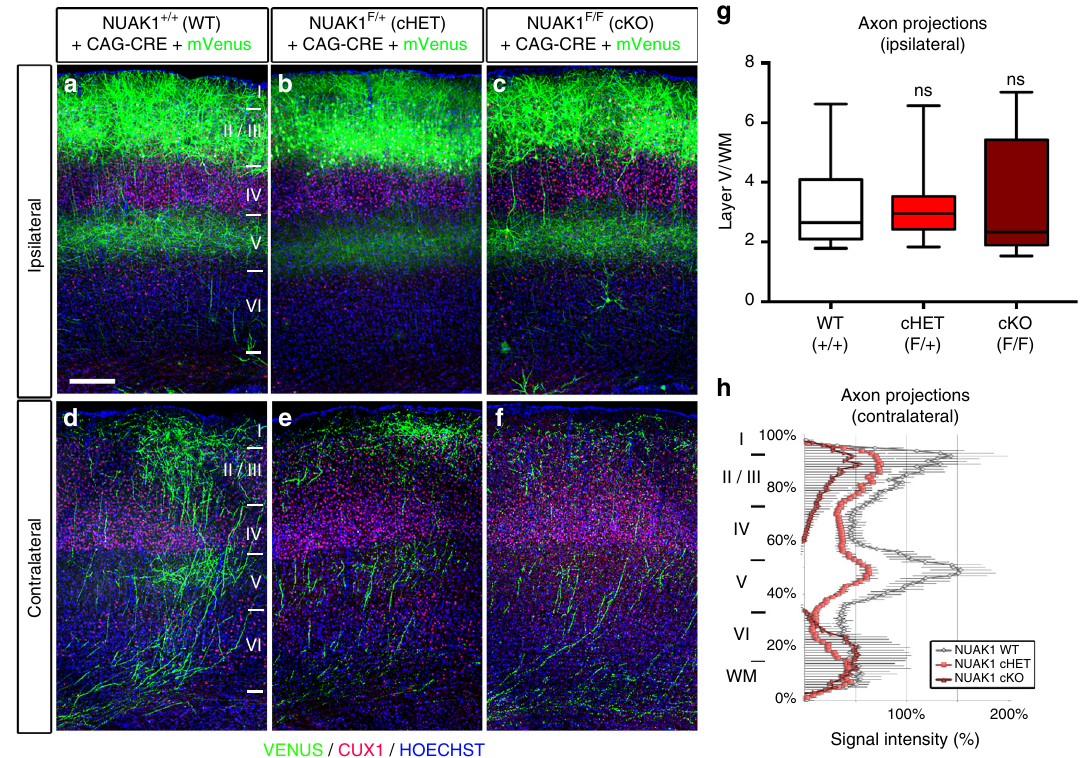
Fig. 5 Cell autonomous reduction in axon branching of NUAK1-de fi cient neurons. a – f Histochemistry of the ipsilateral or contralateral side of NUAK1 + / + , NUAK1 F/ + , and NUAK1 F/F mice at P21 following in utero electroporation with CRE and the fl uorescent protein mVenus. Blue: Hoescht, Red: CUX1 immunostaining. Scale bar: 250 μ m. g – h Quanti fi cation of normalized mVenus fl uorescence in Layer 5 of the ipsilateral cortex ( g ) and along a radial axis in the contralateral cortex ( h ). Data: Average± SEM. N WT = 6, N HET = 13, N KO = 6. Analysis: Mann – Whitney test. ns: p >